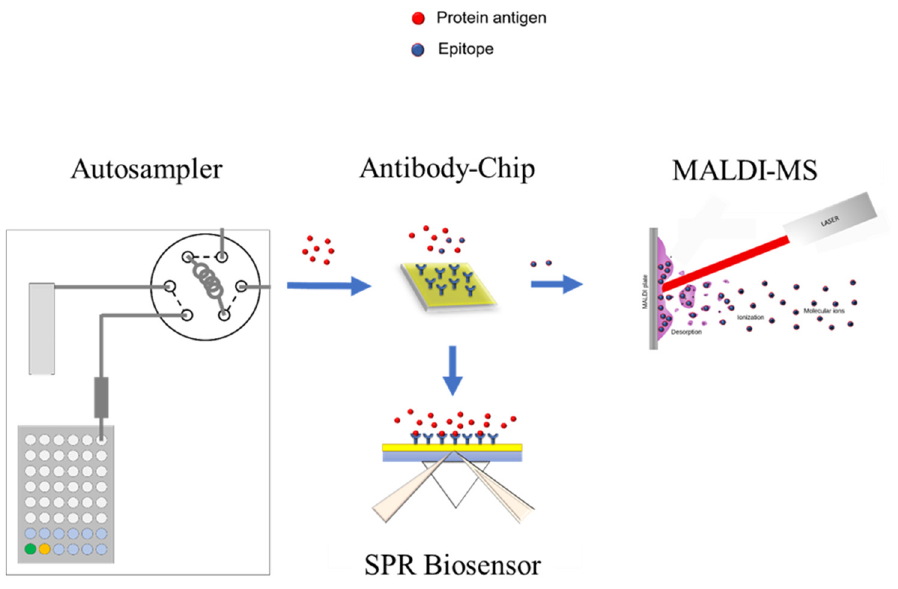
Figure 1. Scheme of the analytical platform for the Chip-SPR–MALDI-MS epitope analyzer. Autosampler unit with SPR chip—MALDI-MS connection and transfer line from SPR valve to MALDI-MS sample target (multiwell plate). Sample injection is performed on the SPR chip containing the immobilized antibody. Peptides injected on the antibody channel provide the SPR sensorgram of the binding epitope(s), and eluted epitope peptide(s) are spotted on the MALDI target plate. K D determinations of the antibody-bound protein and peptide fragments are performed by injecting a dilution series over the SPR chip.